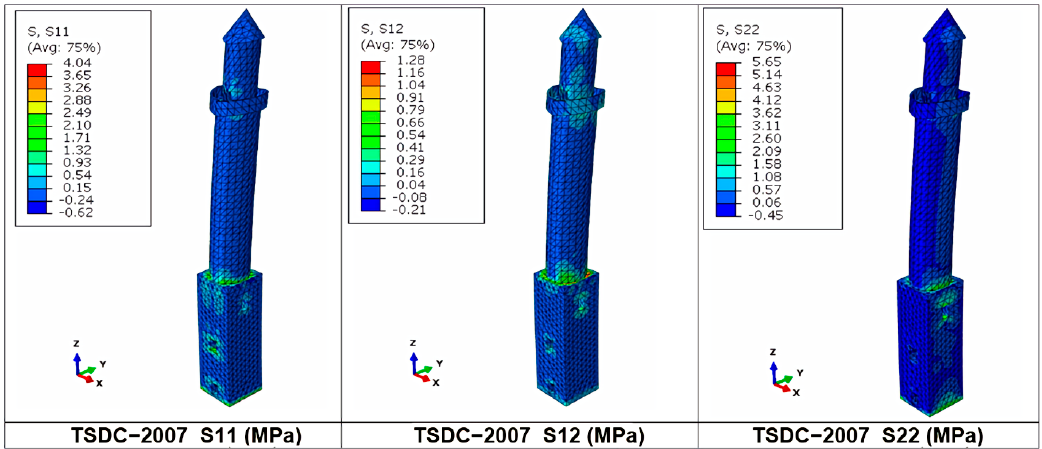
Figure 21. Stress distribution according to TSDC − 2007.